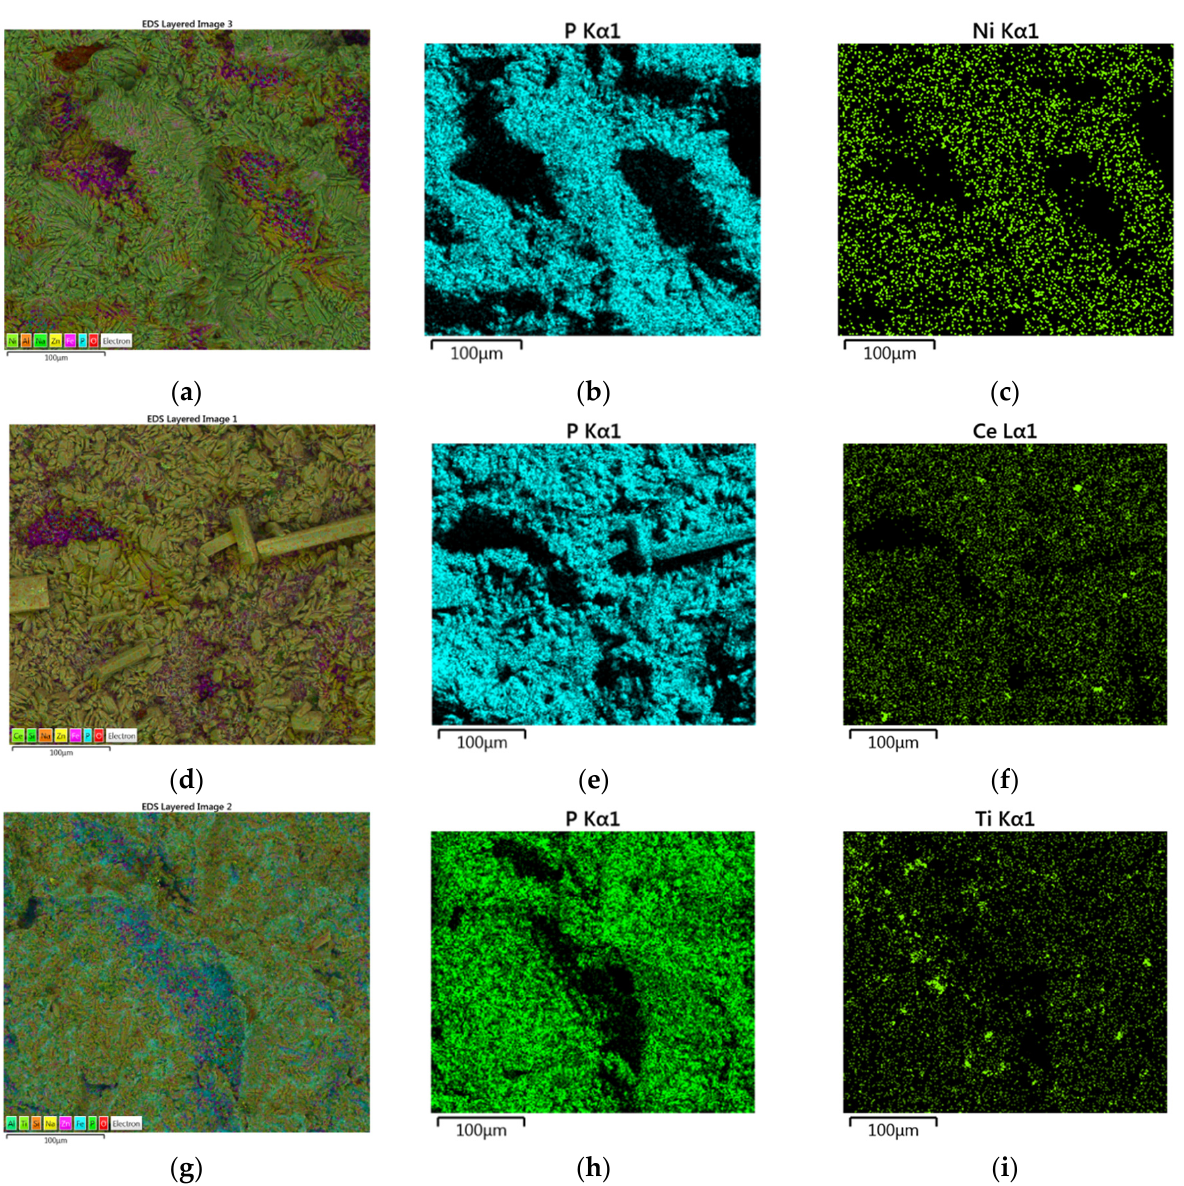
Figure 3. The SEM micrograph displays area analyzed phosphate layer with( a ) Ni 2+ ions, ( d ) Ce 3+ ions and ( g ) Ti 2+ ions. EDS mapping for ( b , e , h ) phosphorus distribution and distribution of( c ) layers Ni 2+ ions, ( f ) Ce 3+ ions and ( i ) Ti 2+ ions on phosphate steel plates. Table 5. The value of thickness for phosphate sample and phosphate samples with Ni 2+ , Ce 3+ , and Ti 2+